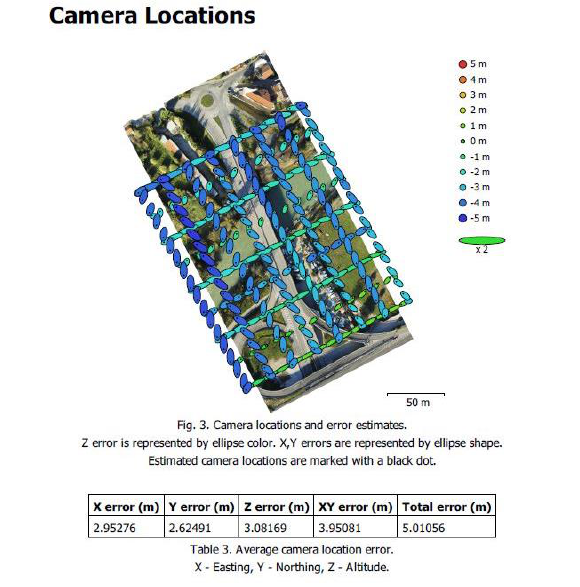
Figure 15: the scale factor and the GPS coordinates taken physically on site on Google model.